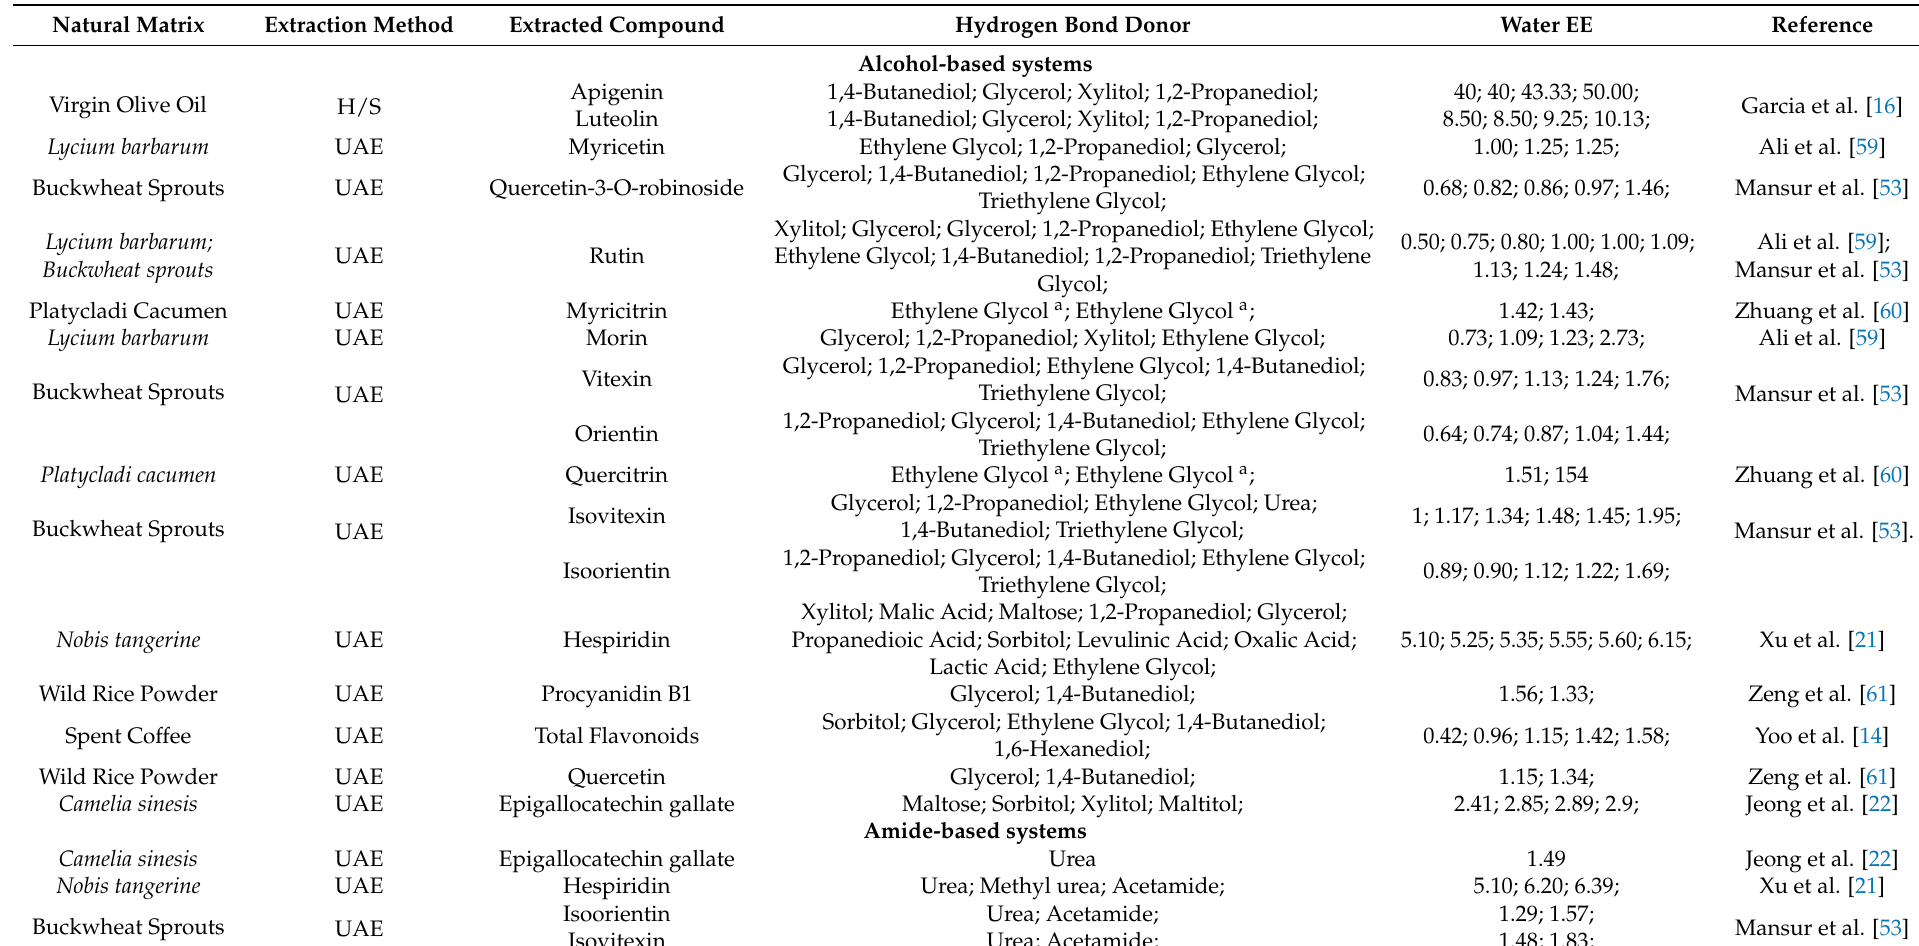
Table 1. Correlation between the natural matrix, extraction method, and DES based on ammonium salts (choline chloride and betaine) and the effect of different HBDs on the extraction efficiency of different flavonoids compared with water